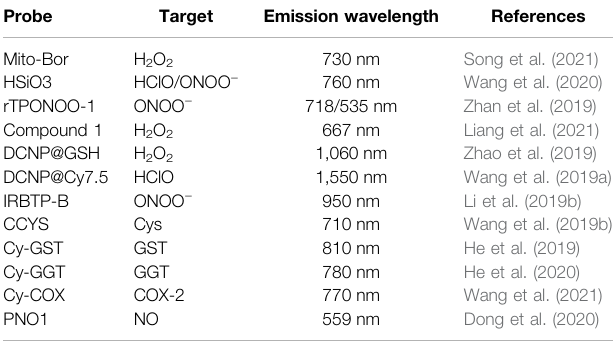
TABLE 1 | Properties of PF-related fl uorescent